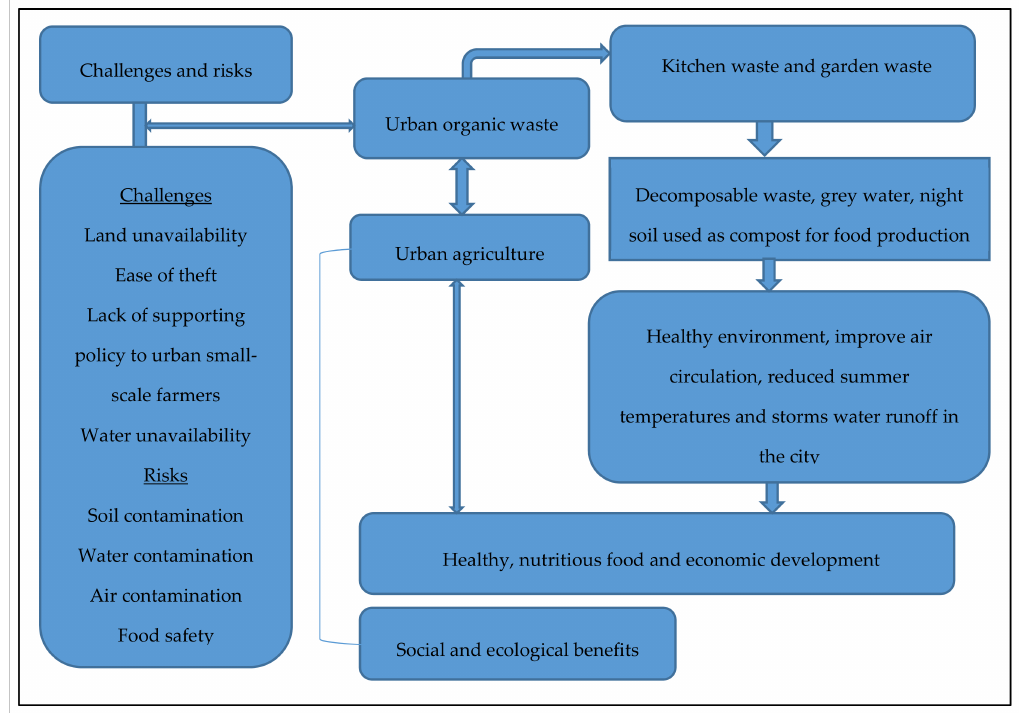
Figure 4. Conceptual framework of a sustainable model of utilising and managing waste through urban